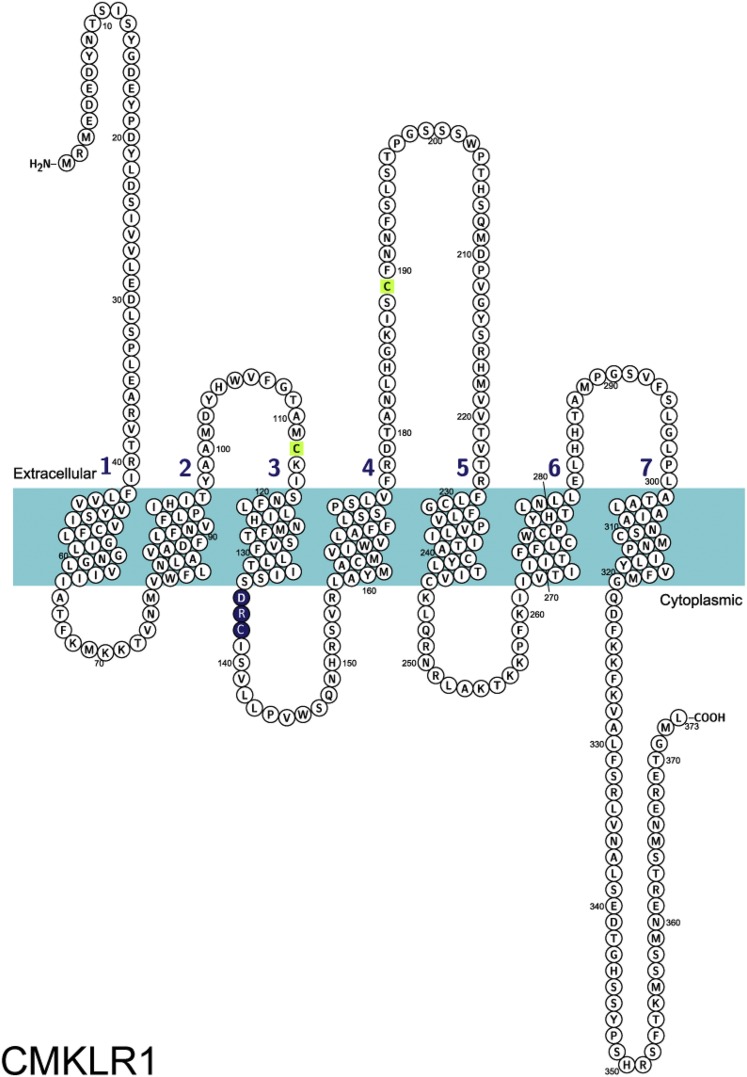
Amino acid sequence of chemerin receptor 1: Cys112 andCys189 (green) are predicted to form a disulfide bond based on sequence similarity, and the G protein–binding motif is shown in blue. Figure made using UniProt (Q99788) and Protter (Omasits et al., 2014).